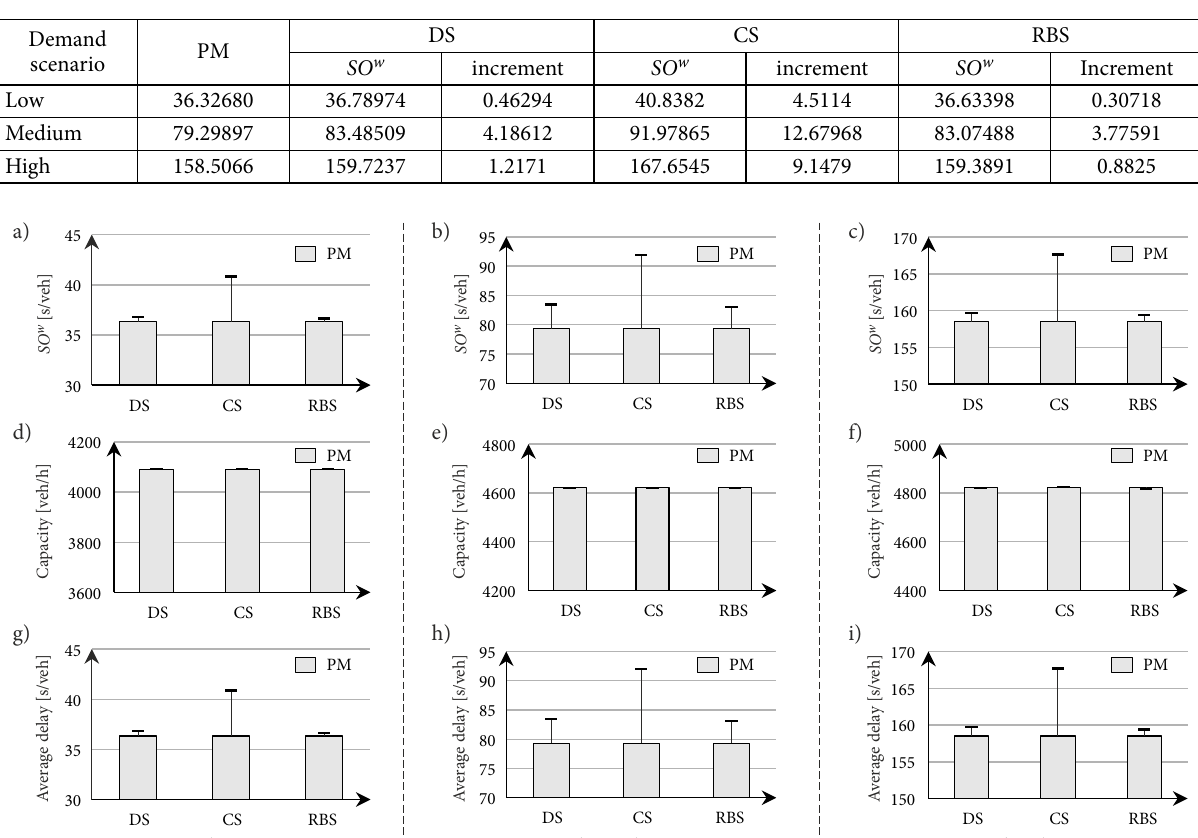
Figure 8. Performance evaluation results